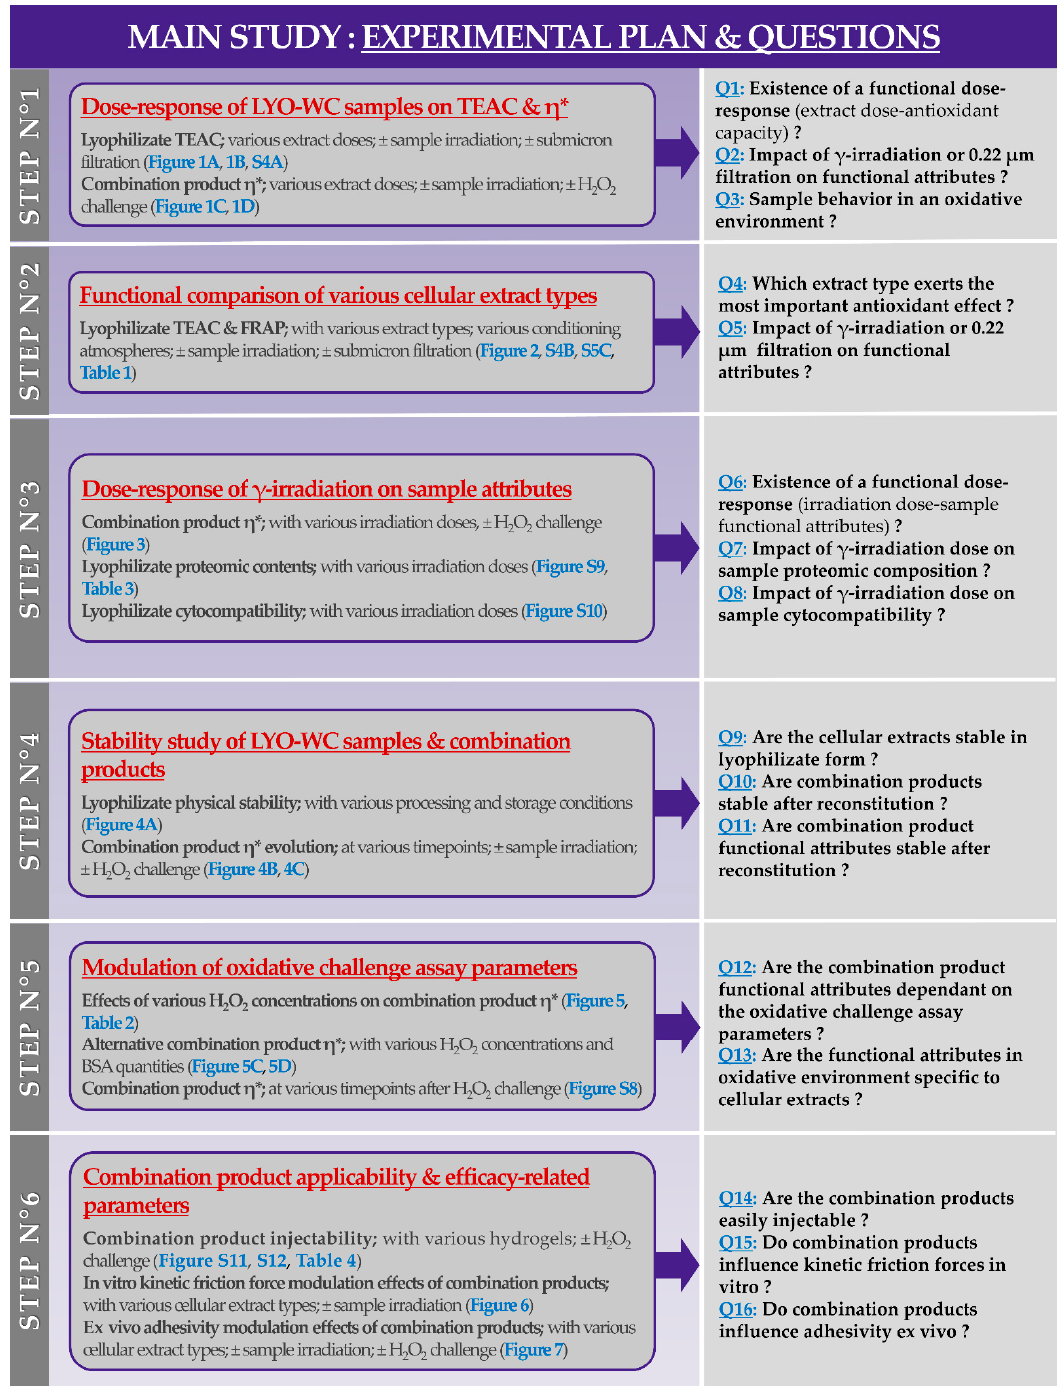
Figure A3. Step-by-step presentation of the experimental plan of the main study, with reference to the questions addressed by the various assays and reference to the obtained experimental results (i.e., for each assay). A distinction is made between the functional attributes of the cellular extracts in lyophilizate form (i.e., intrinsic antioxidant activity) and the functional attributes of the cellular extracts reconstituted in HA (i.e., mainly the viscosity modulating functions, mediated by oxidative stress). References to the corresponding experimental results are provided (i.e., in blue font; figures, and tables). η *, complex viscosity; BSA, bovine serum albumin; FRAP, ferric reducing antioxidant power; HA, hyaluronic acid; LYO-WC, lyophilized whole-cell fraction; TEAC; Trolox equivalent antioxidant